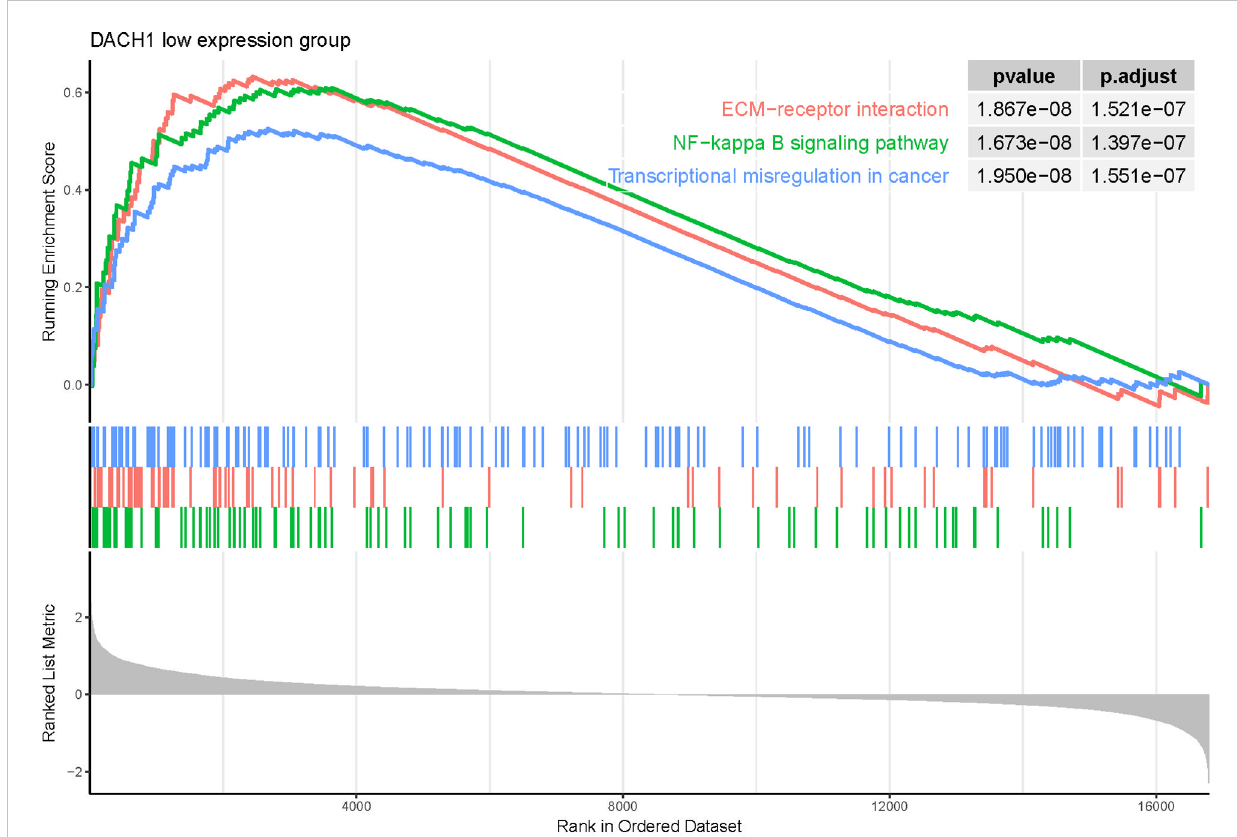
FIGURE 10 GSEA results showed that the three pathways — transcriptional misregulation in cancer, ECM-receptor interaction, and the NF-kappa B signaling pathway — were activated in the DACH1 low expression